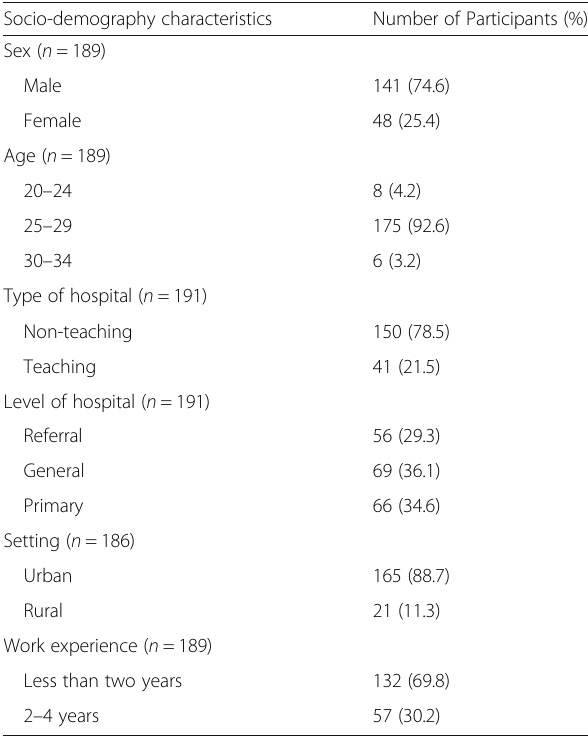
Table 1 Socio-demographic characteristics of study participants, Ethiopia, 2015 Socio-demography